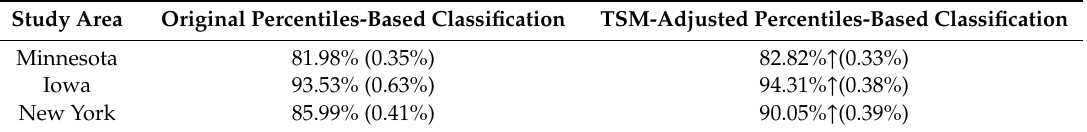
Table 3. Overall classification accuracies achieved by the use of original percentiles and TSM-adjusted percentiles for the three study areas. The average values and standard deviations (in parentheses) of the overall accuracies were derived from ten independent classification experiments. Note that the upward arrows indicate that the overall accuracies obtained using the TSM-adjusted percentiles are significantly (at the 5% level) higher than that obtained using the original percentiles.